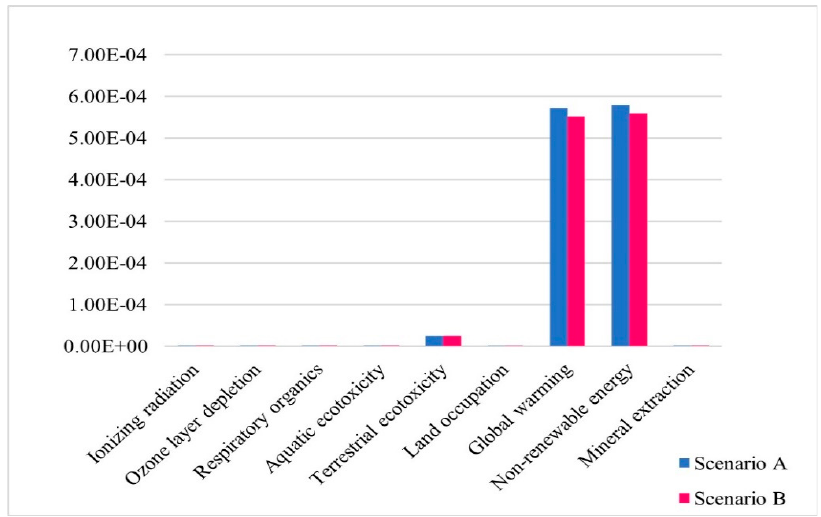
Figure 5. Normalized potential impacts of scenario A and B, IMPACT 2002+.